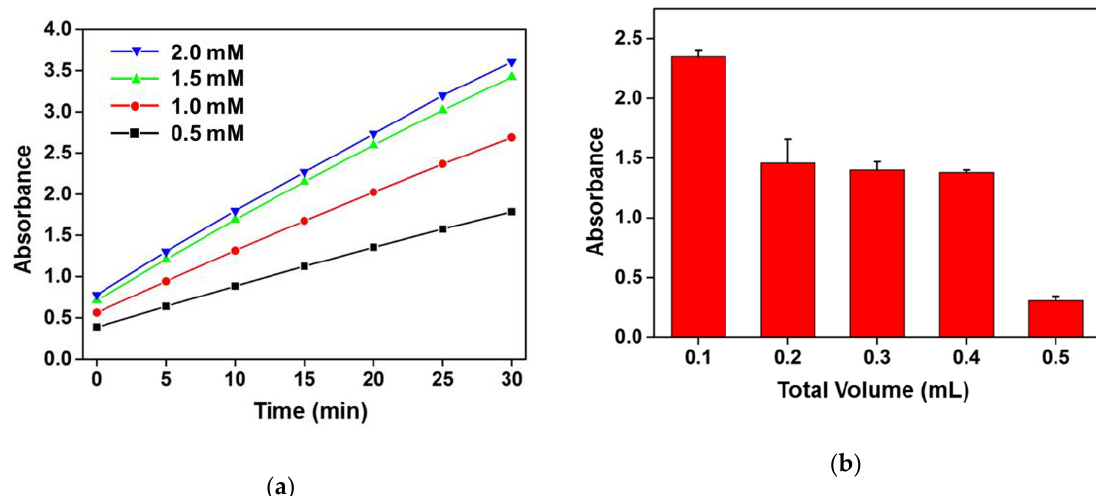
Figure 3. Optimization of enzymatic colorimetric change reactions for the sensitive detection of target bacteria: ( a ) Colorimetric response depending on the CPRG concentration reaction with the same concentrated E. coli O157:H7 lysate according to the duration of reaction time (up to 30 min); ( b ) Absorbance responses upon the same amount of CPRG and E. coli O157:H7 lysate in various total reaction volumes from 0.1–0.5 mL after 30 min of reaction time.